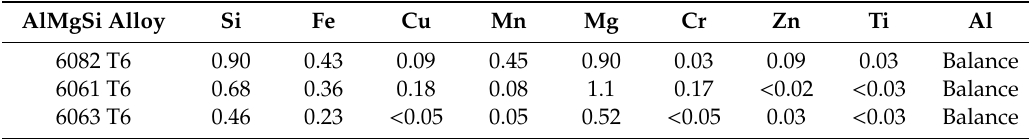
Table 1. Chemical nominal composition (wt%) of AlMgSi alloys. AlMgSi